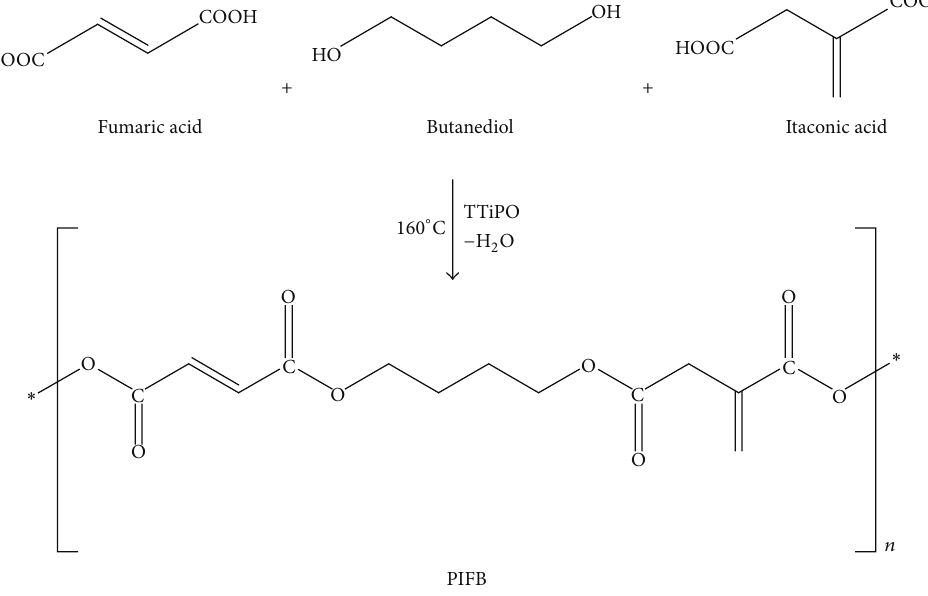
Scheme 1: Synthetic route of